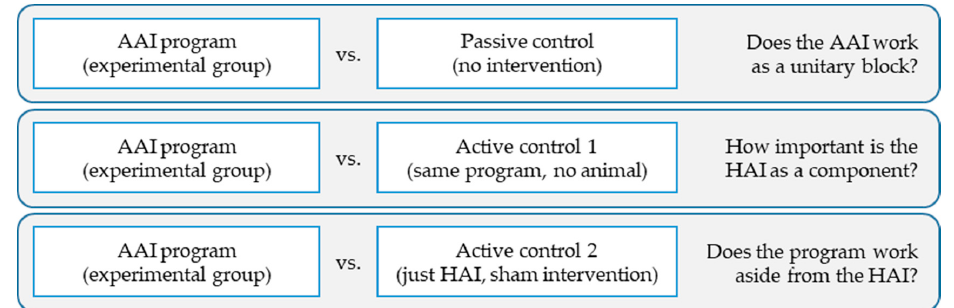
Figure 1. Utility of di ff erent control groups (adapted from L ó pez-Cepero [21]). AAI = Animal-assisted intervention. HAI = Human-animal